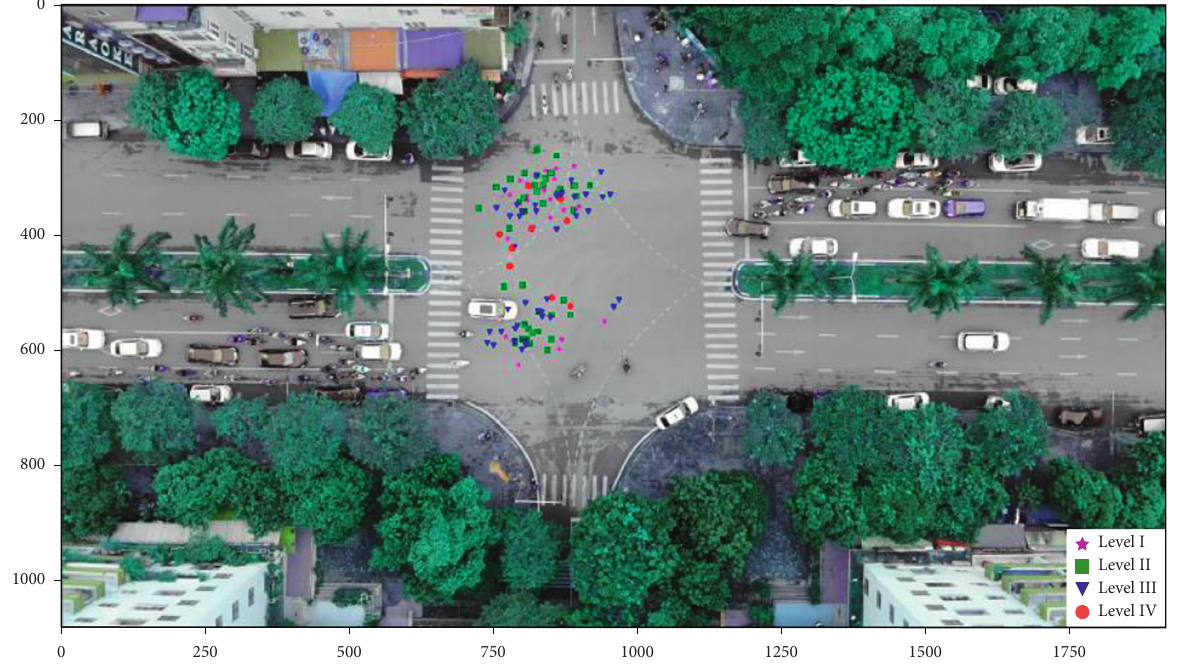
Figure 11: Plane of the distribution of conflict points at the